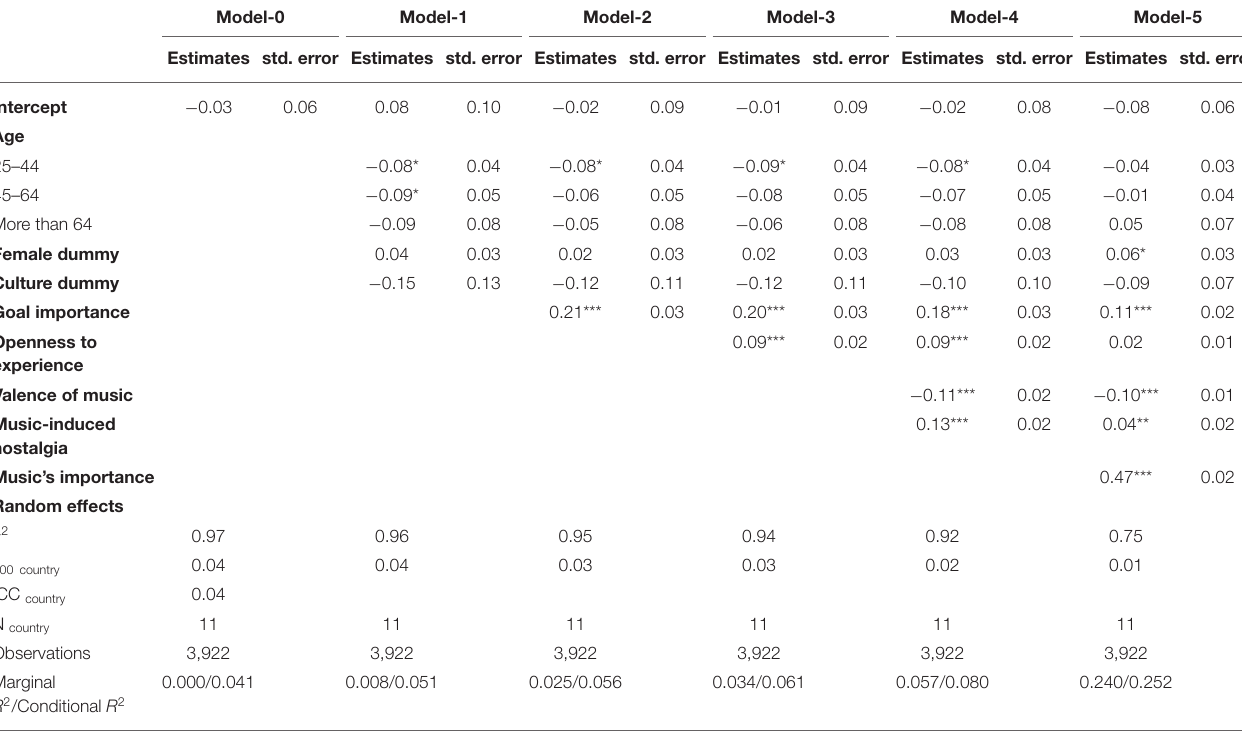
TABLE 6 | Overview of main statistical outcomes of multilevel regression models testing which variables predict the rated efficiency of music in obtaining “Venting negative emotions.”